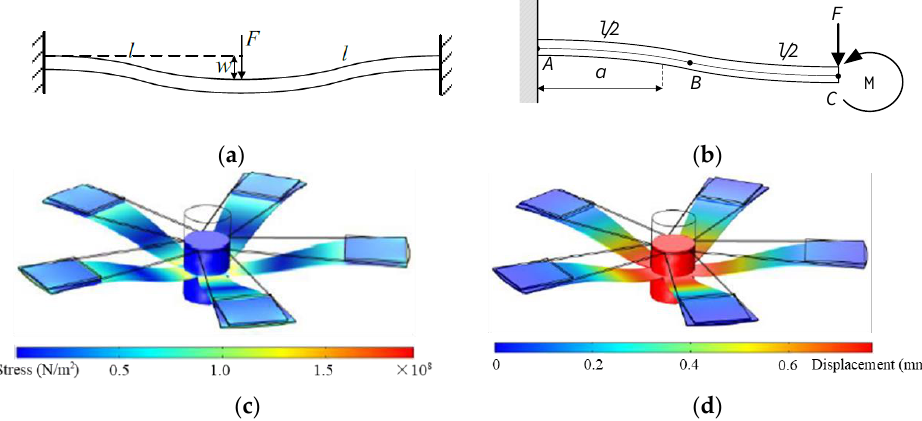
Figure 2. Schematic diagram of experimental test system.